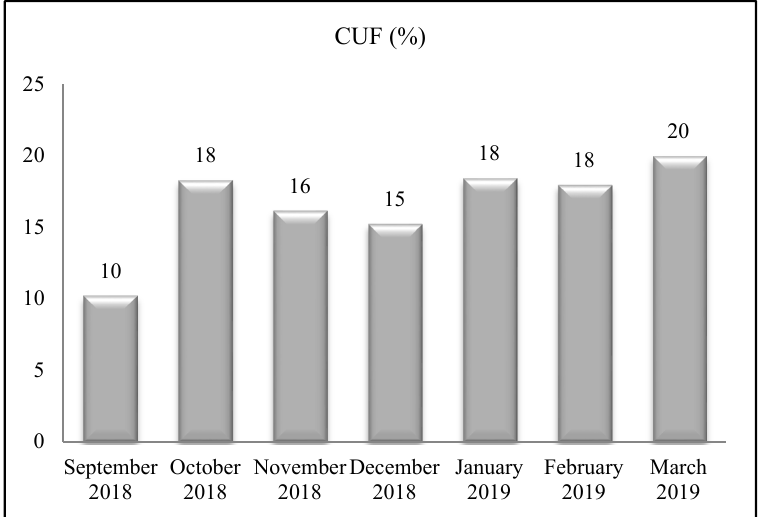
Figure 11. Month wise CUF.